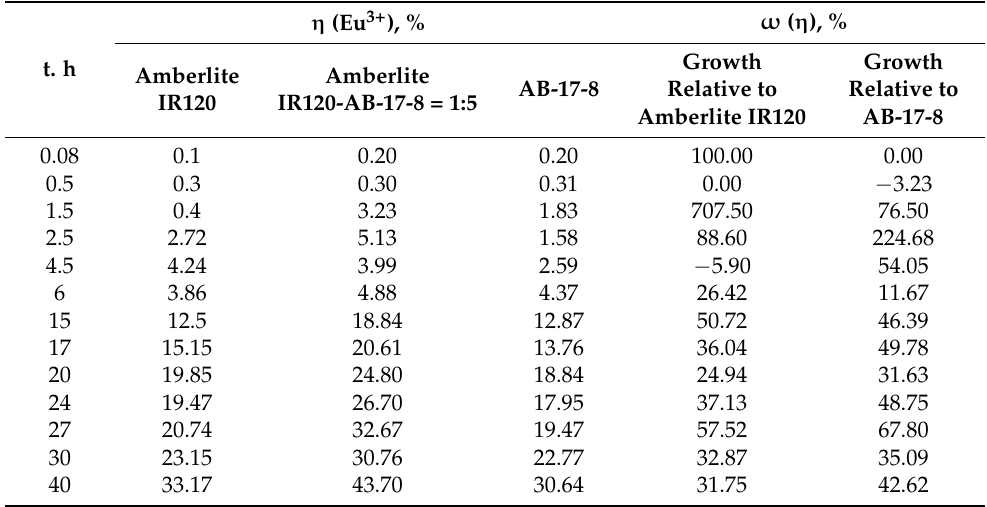
Table 4. Increase of extraction degree in interpolymer pair Amberlite IR120:AB-17-8 = 1:5 compared with individual ion exchangers.